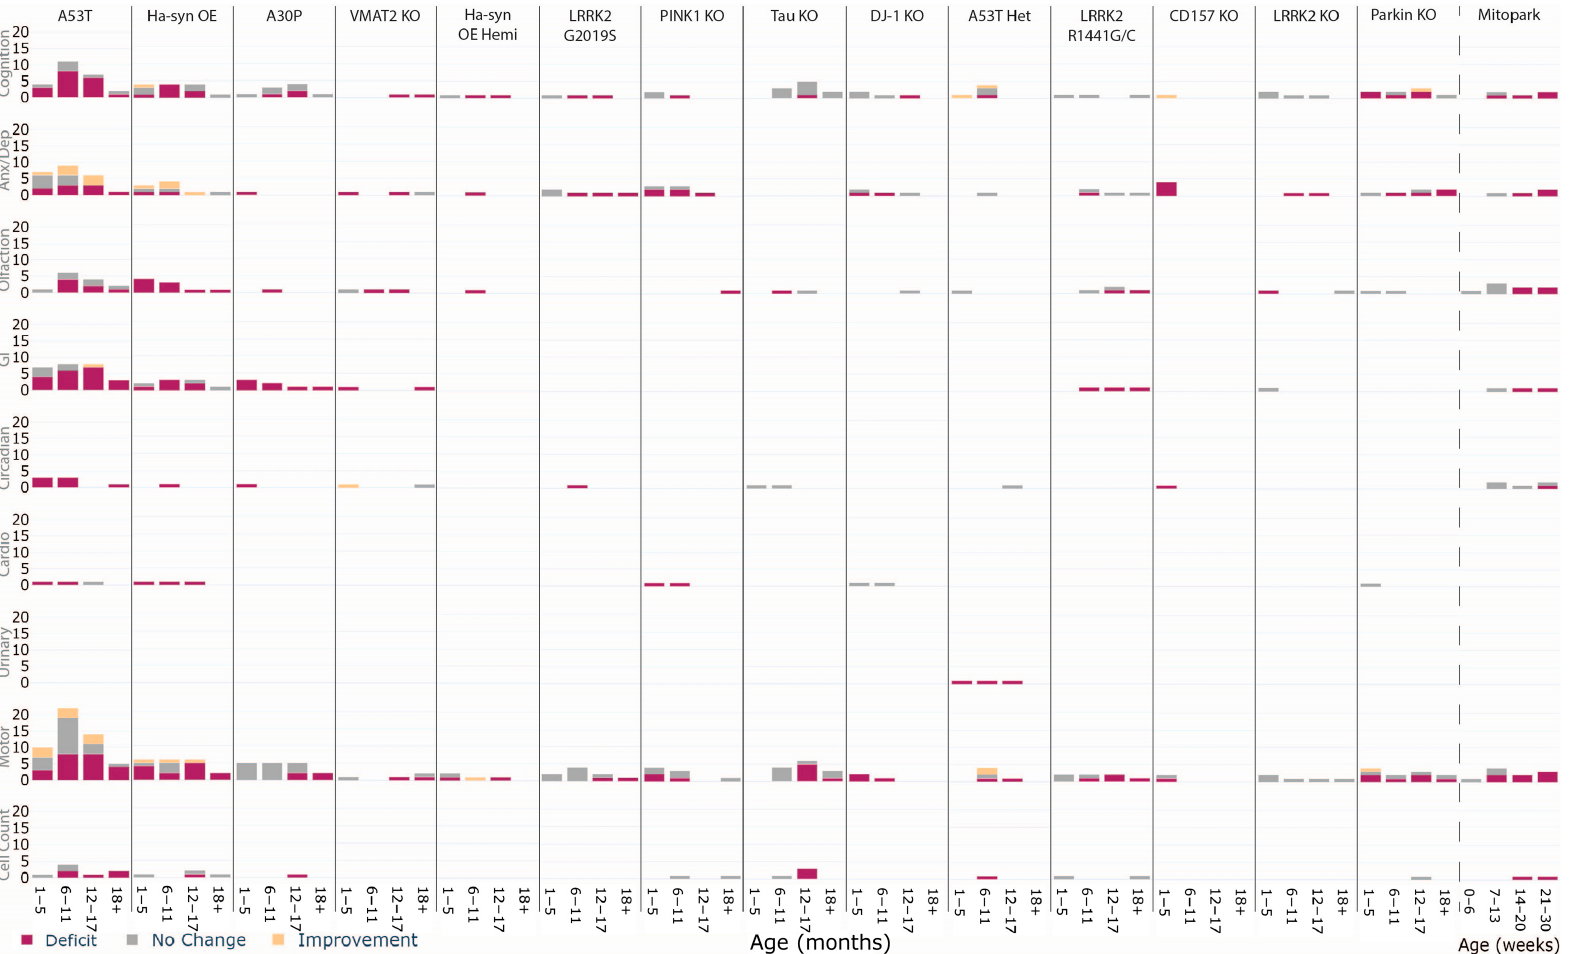
Figure 5. Age-dependent impairments in PD rodent models. Stacked bar chart of phenotypic observations showing deficits (aligning with human PD), no change, and improvement (opposite effect to expected). Number of observations are binned across age brackets (1–5; 6–11; 12–17 and 18+ months of age or 0–6; 7–13; 14–20; 21+ weeks) and observations can represent many from a single